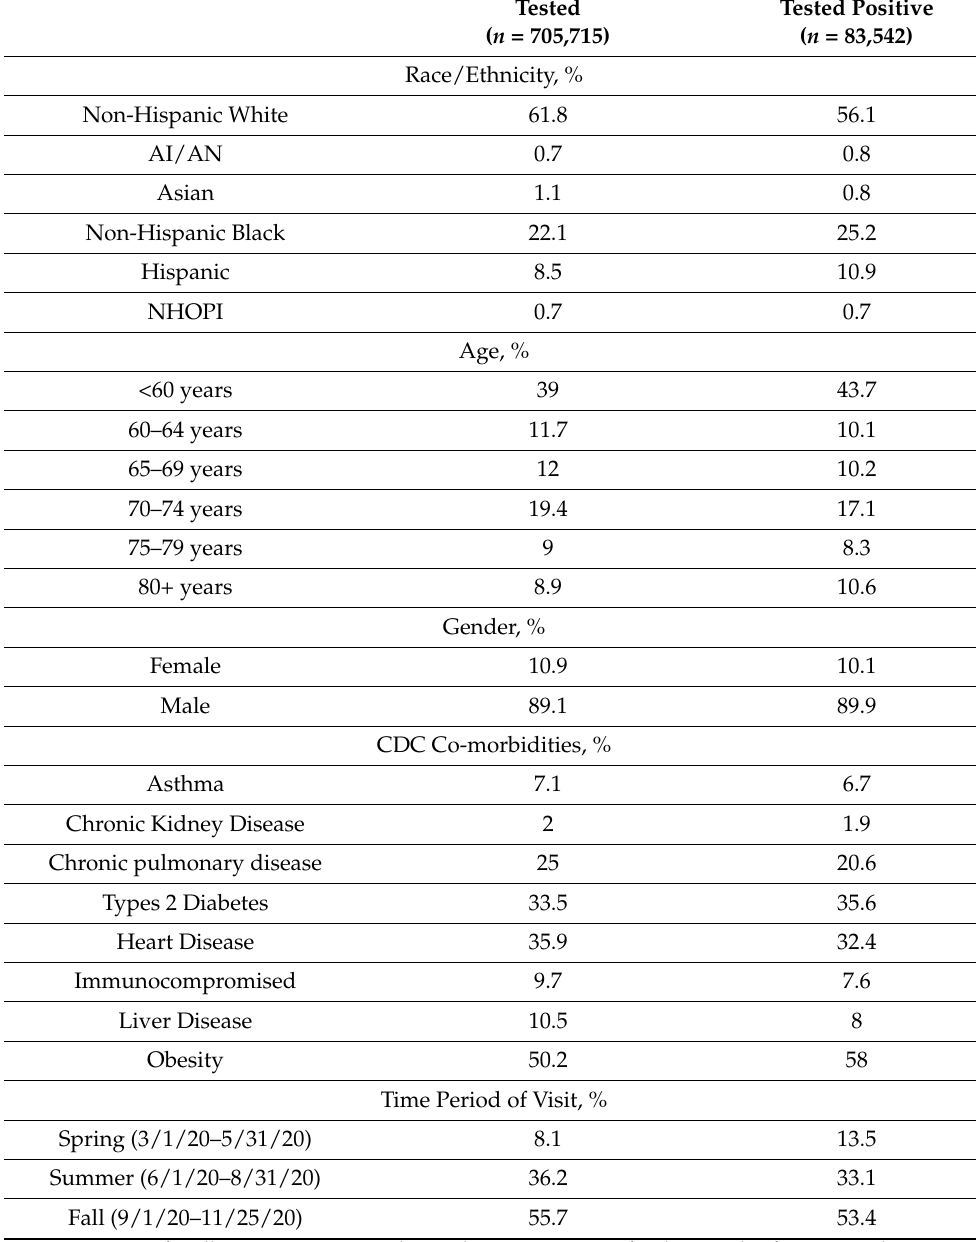
Table 1. Sample characteristics for veterans who received a COVID-19 test at a Veterans Health Administration (VHA) facility and for veterans who tested positive for COVID-19. Tested ( n =